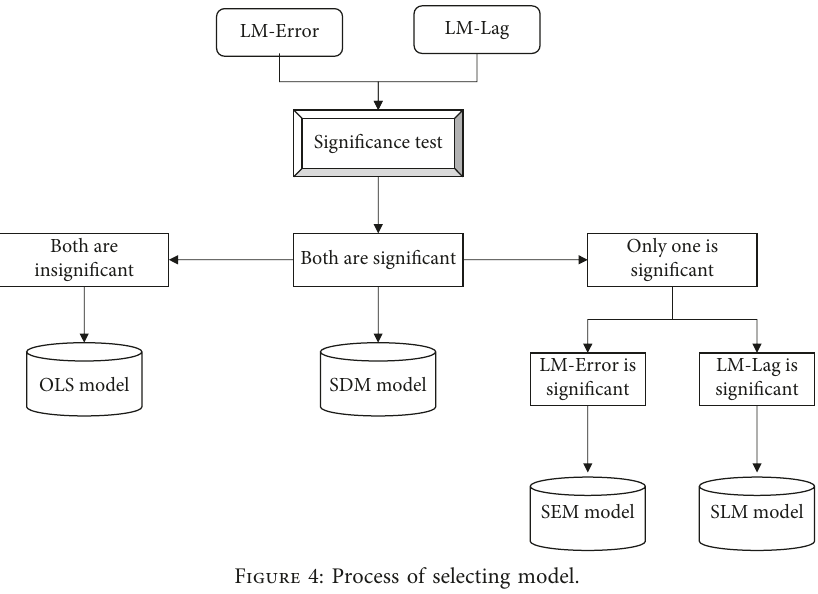
Figure 4: Process of selecting model.